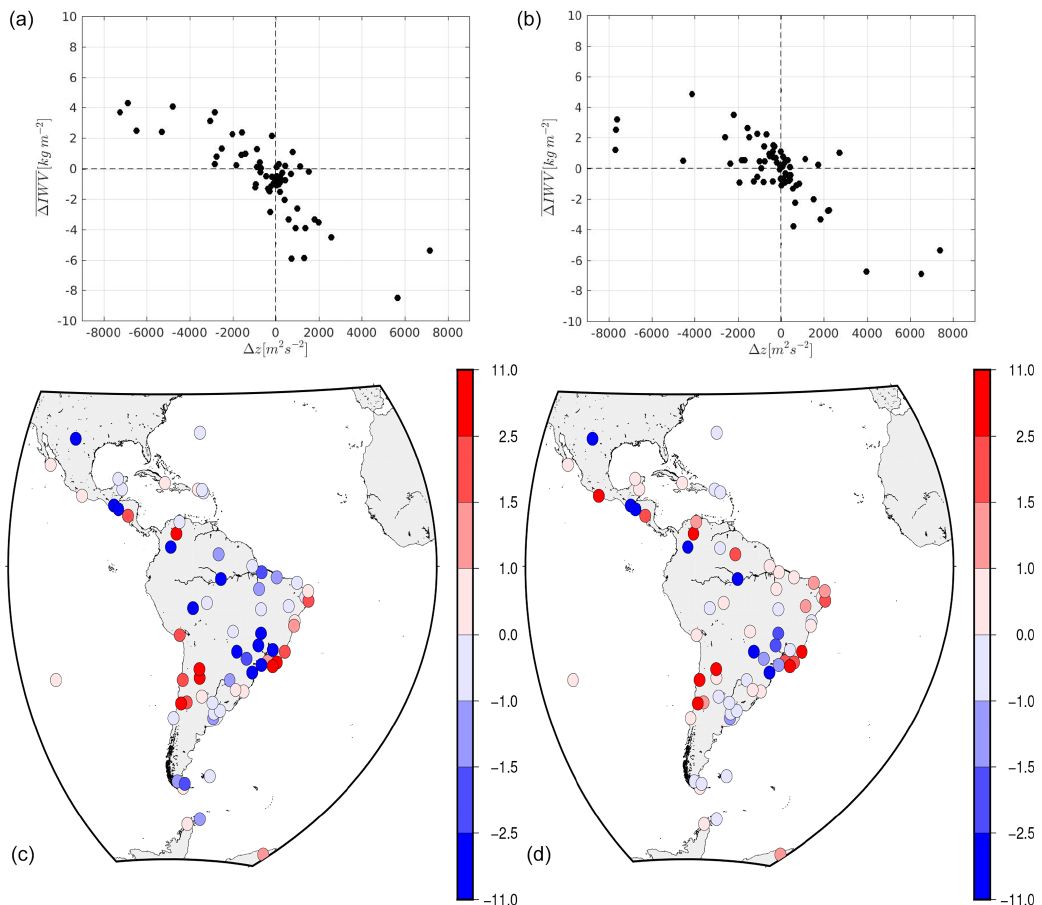
Figure 2. (a, b) Values of (cid:49) IWV ( (cid:49) IWV = IWV GNSS − IWV NWM ) as a function of the geopotential differences ( (cid:49)z ). Results for MERRA- 2 are shown in panel (a) , and results for ERA-Interim are displayed in panel (b) . (c, d) Geographical distribution of (cid:49) IWV for MERRA-2 (c) and ERA-Interim (d)